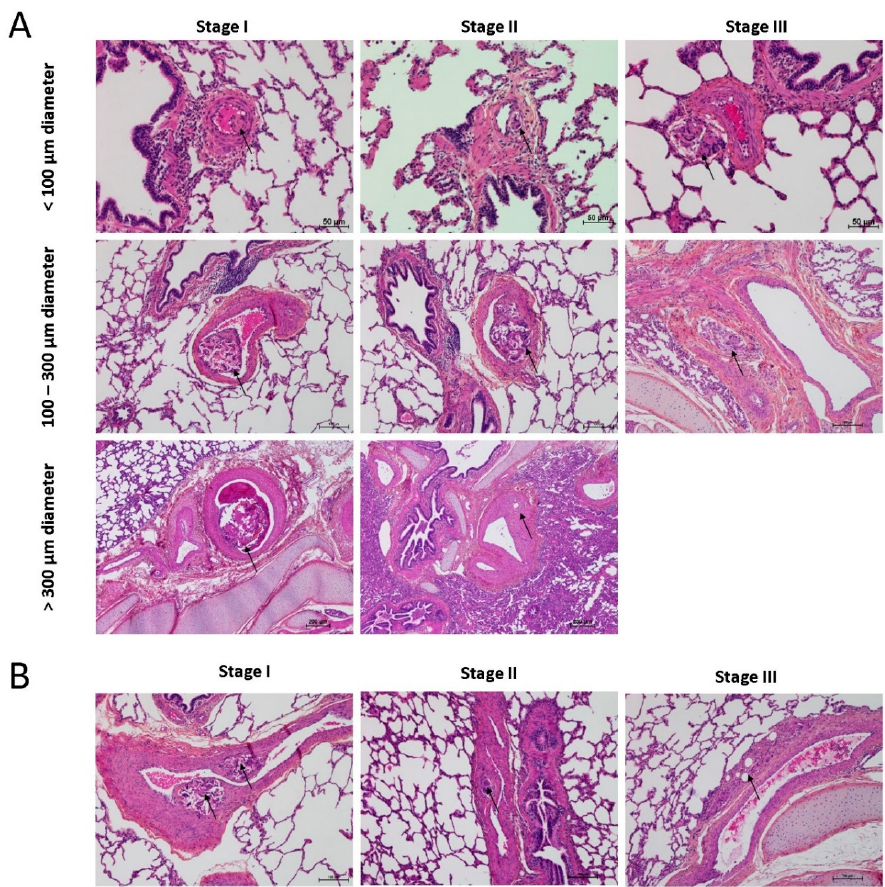
Figure 3. Histopathology of right lower lobes of the animal model of chronic thromboembolic pulmonary hypertension (CTEPH) showing axial ( A ) and longitudinal ( B ) arterial cuts of the 3 stages of angiophagy (3 rows). Arrows show embolic specimen position. Stain is hematein–eosin–saffron.